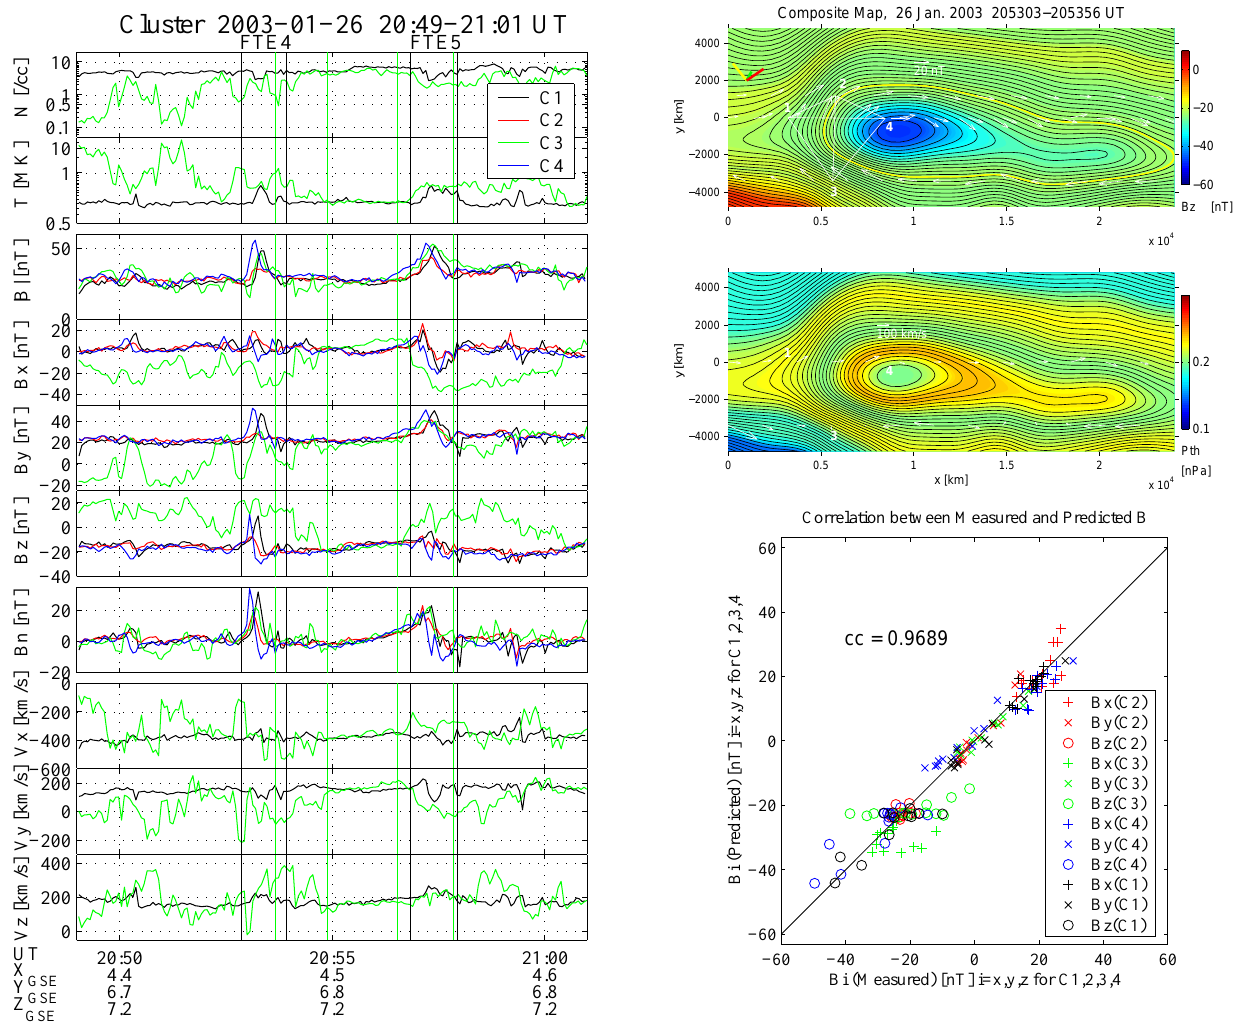
Fig. 6. Cluster data on 26 January 2003, 20:49–2:101 UT. The format is the same as in Fig. 1. The average GSE location of Cluster was (4.5, 6.8, 7.2) R E . Time intervals between the black vertical lines were used for the FTE reconstruction, while those between the green vertical lines were for determining the magnetopause normal for FTEs 4 and 5, respectively, from MVAB with constraint h B n i =0, using C3 magnetic field measurements.